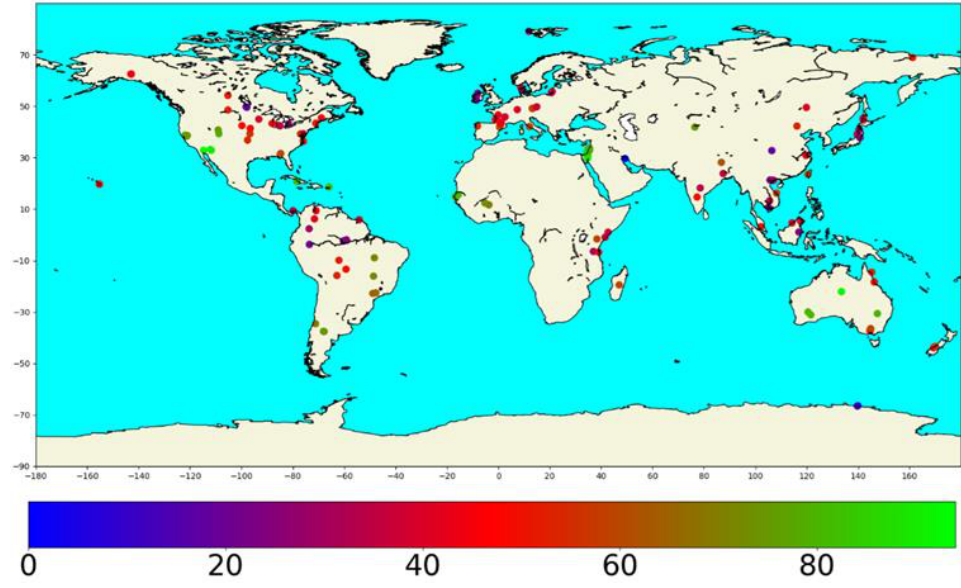
Figure 53. Percentage and geographic breakdown of valid Level-1 products.